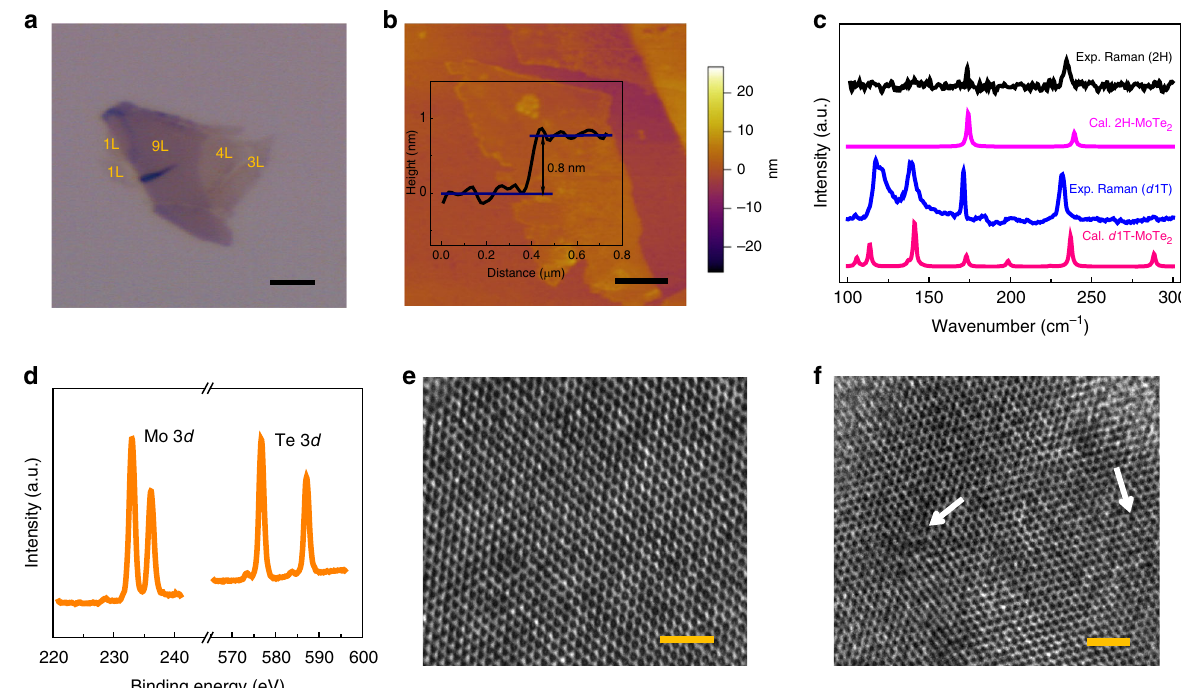
Fig. 1 Phase transition of d 1T-MoTe 2 . a OM image of d 1T-MoTe 2 /Pt, scale-bar, 3 μ m. b AFM image and corresponding height pro fi le of monolayer d 1T-MoTe μ m. c Experimental and calculated Raman spectra of 2H-MoTe 2 , scale-bar, 0.5 images of 2H and d 1T-MoTe 2 (arrows denote Te defects, scale-bar, 2